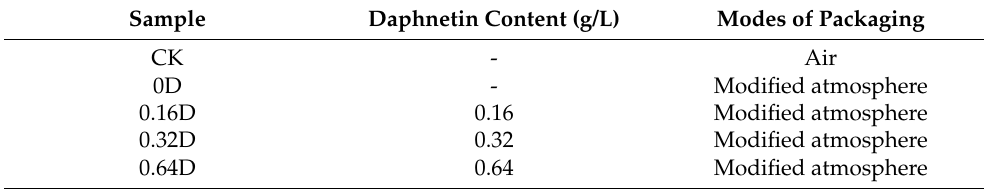
Table 1. Sample preparation with different daphnetin contents and modes of